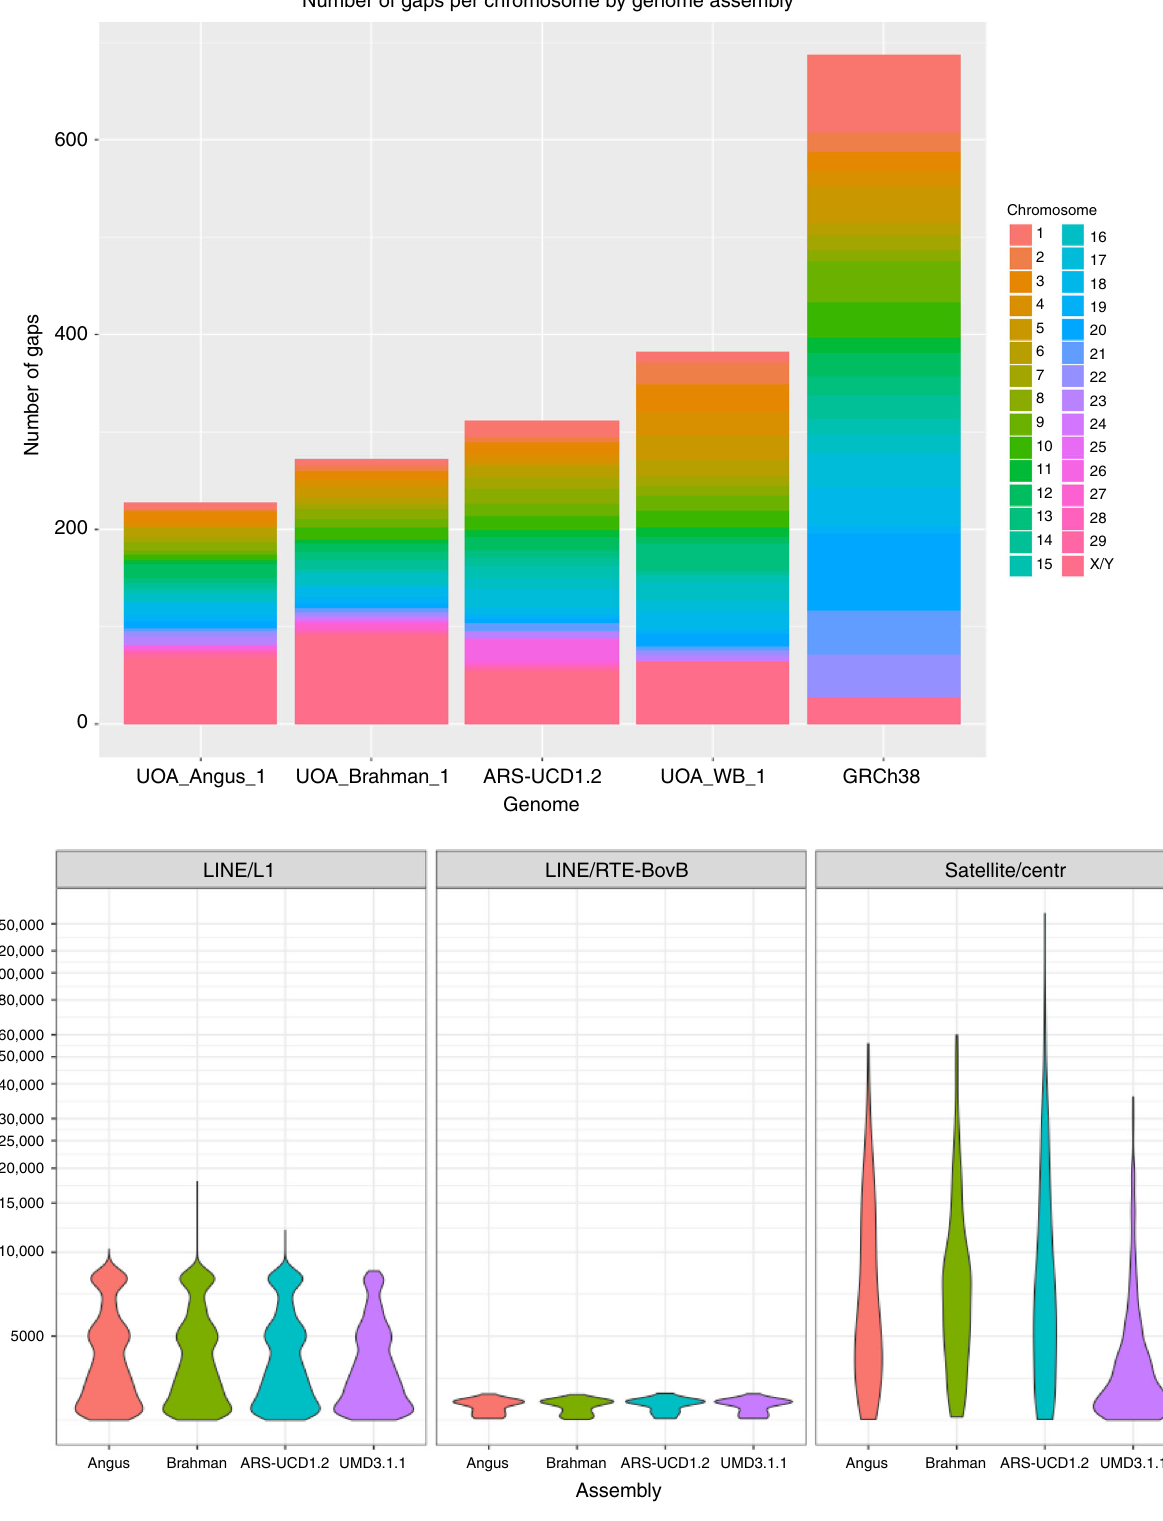
Fig. 2 Sequence contiguity and resolution of repeats. a Barplot of the number of gaps by chromosomes between various mammalian assemblies. b Violin plot of repeat families fi ltered for those >2.5 kb for LINE/L1, LINE/RTE-BovB, and satellite/centromeric